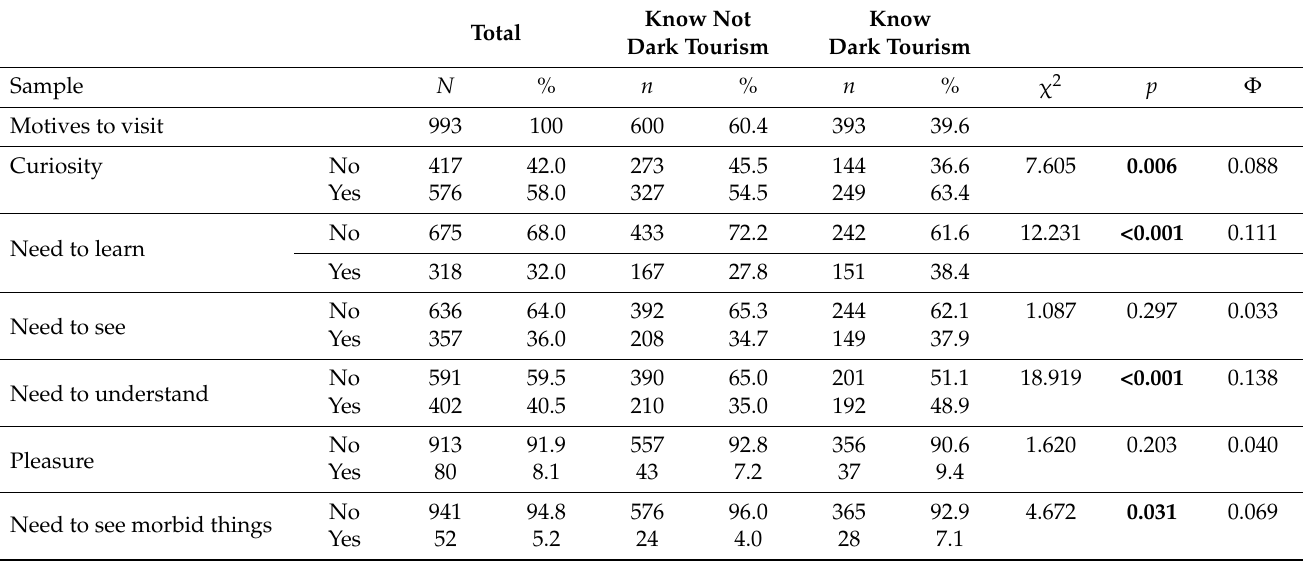
Table 3. Dark tourism